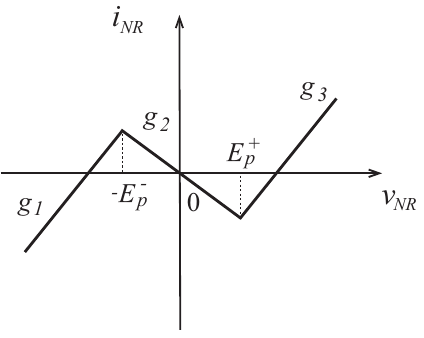
Figure 2. v NR − i NR characteristic of Nagumo’s 3SPWL resistor.